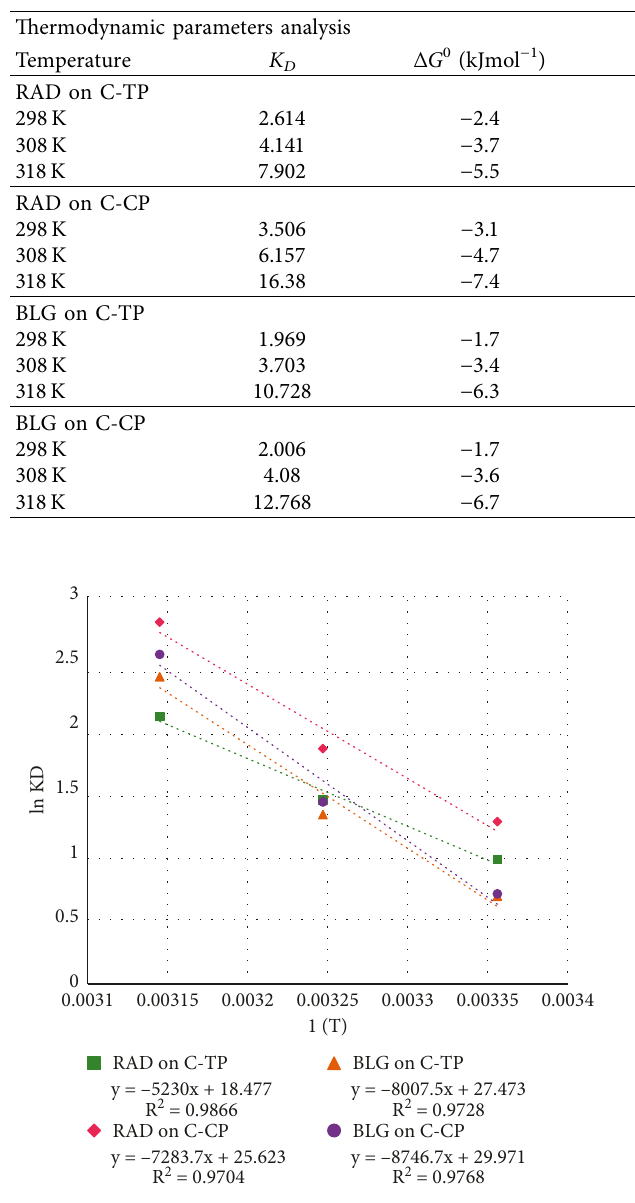
Figure 19: A comparison of the thermodynamics parameters for the adsorptive dye removal performance of acid-treated bio- sorbents. Initial pH � 5, final pH for RAD on C-TP and C-CP � 4, BLG on C-TP � 4.5, and BLG on C-CP �